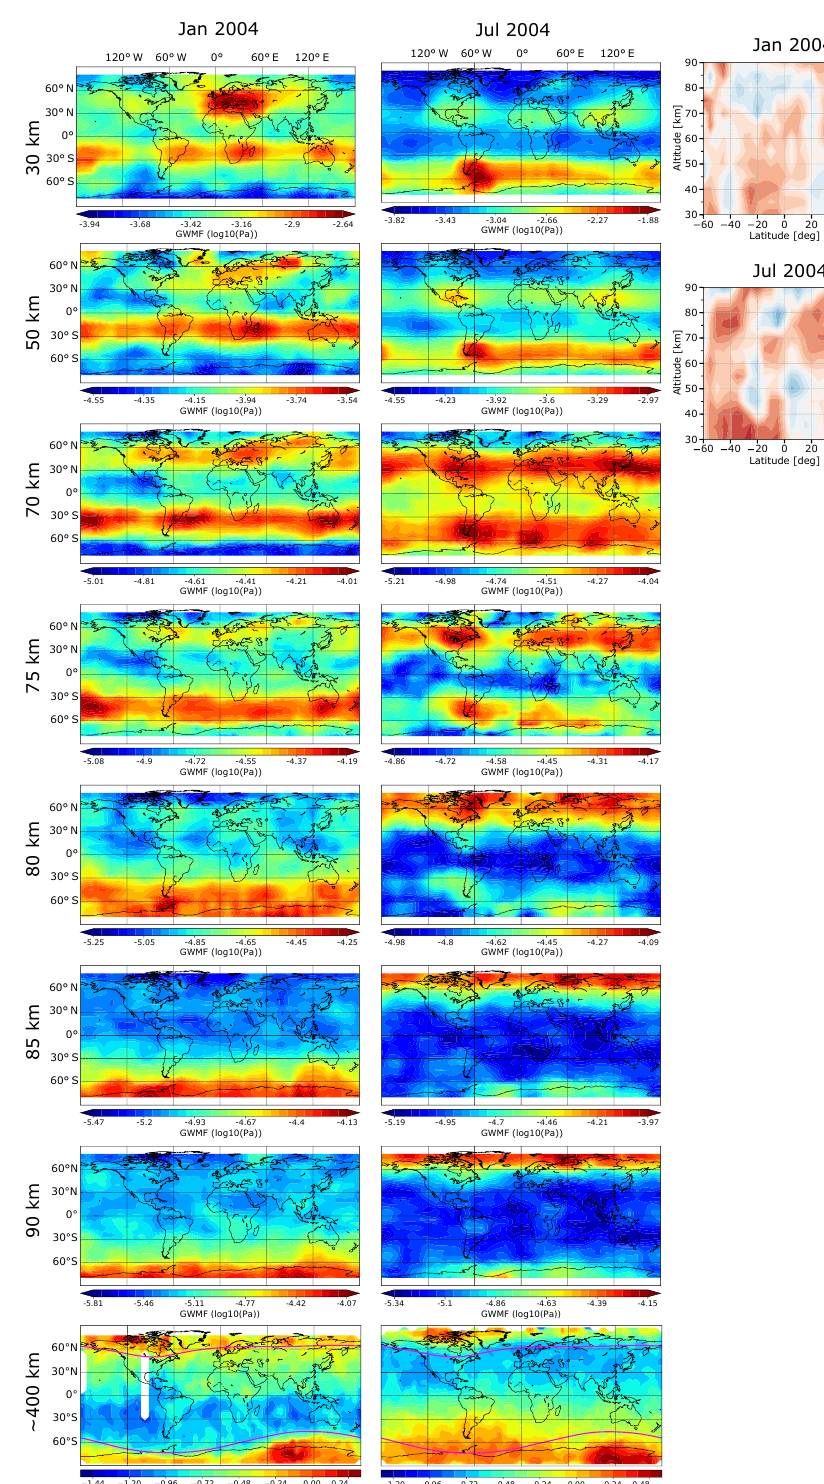
Figure 6. Global maps of GWMF derived from SABER observations (1st–7th rows, 1st two columns) and the ARDF derived from CHAMP observations (last row, 1st two columns), as well as correlation coefficients (last columns) for January and July 2004. Only data equatorward of 60 ◦ magnetic latitudes (magenta lines) on CHAMP global maps are used for calculating